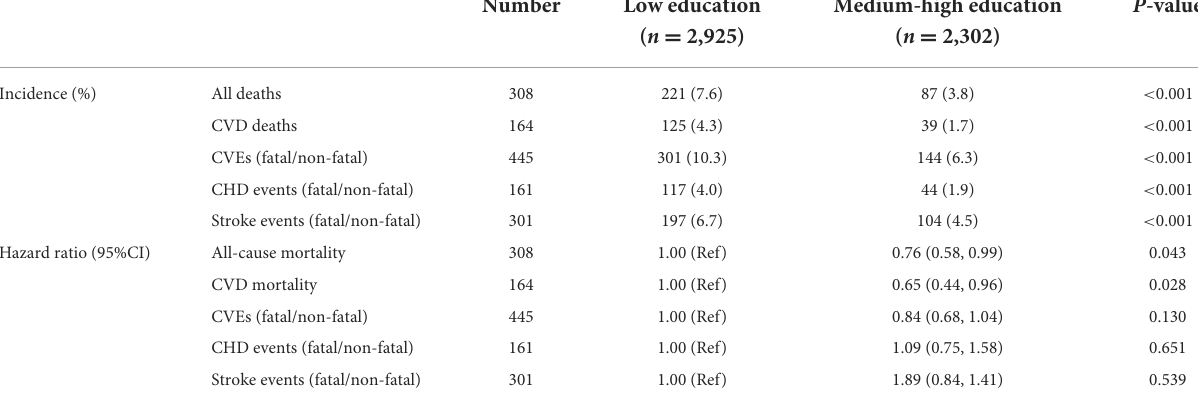
TABLE 3 Association Between education levels and